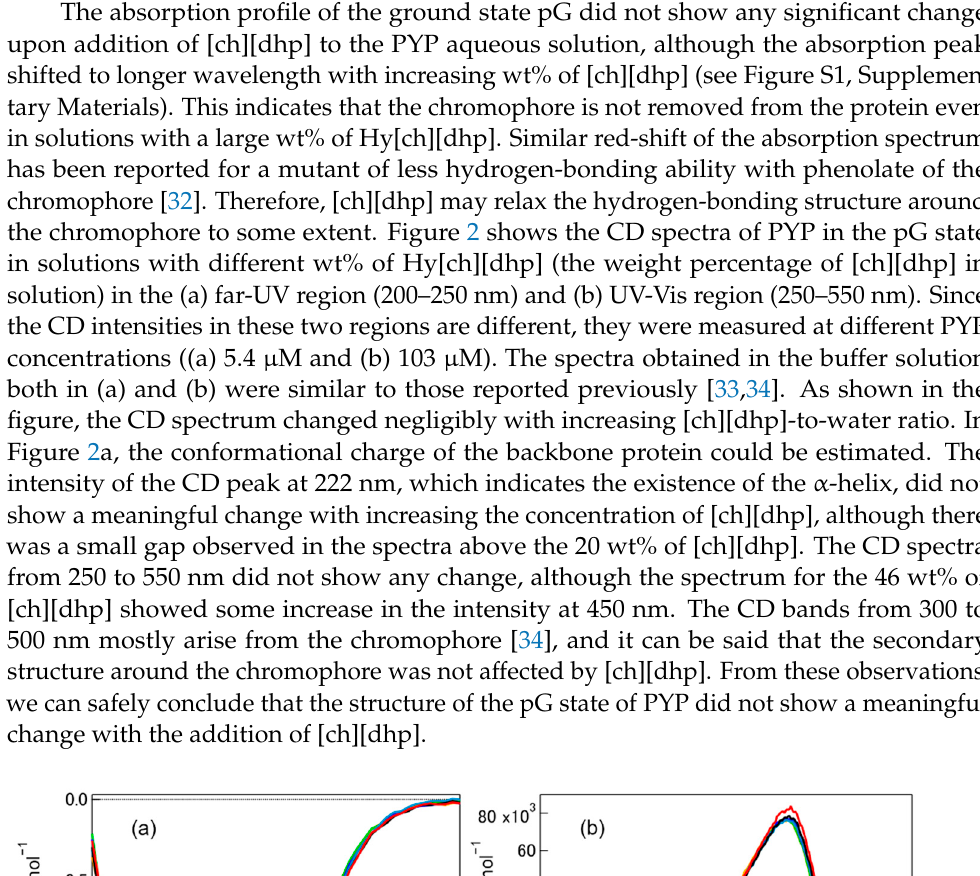
Figure 1. Simplified PYP photocycle model and chemical structure of [ch][dhp].